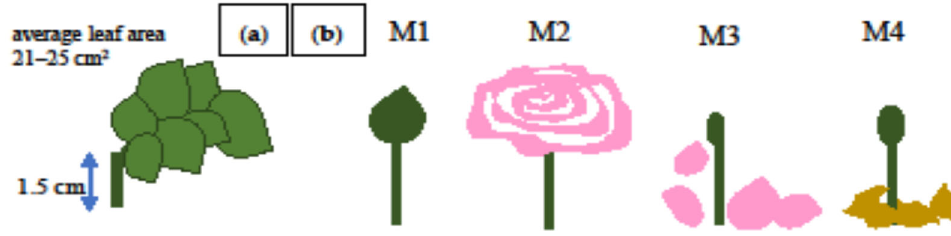
Figure 1. The single-node leaf cutting ( a ) and shoots of following phenological stages in terms ( b ) of Rosa ‘Maiden’s Blush’ with the dates of harvesting cuttings. Phenological stages ( b ): M1—flower buds closed in formed inflorescence (1.06); M2—flowers in an inflorescence open (9.06); M3—immediately after petal shedding (17.06); M4—7–14 days after petal fall (28.06).